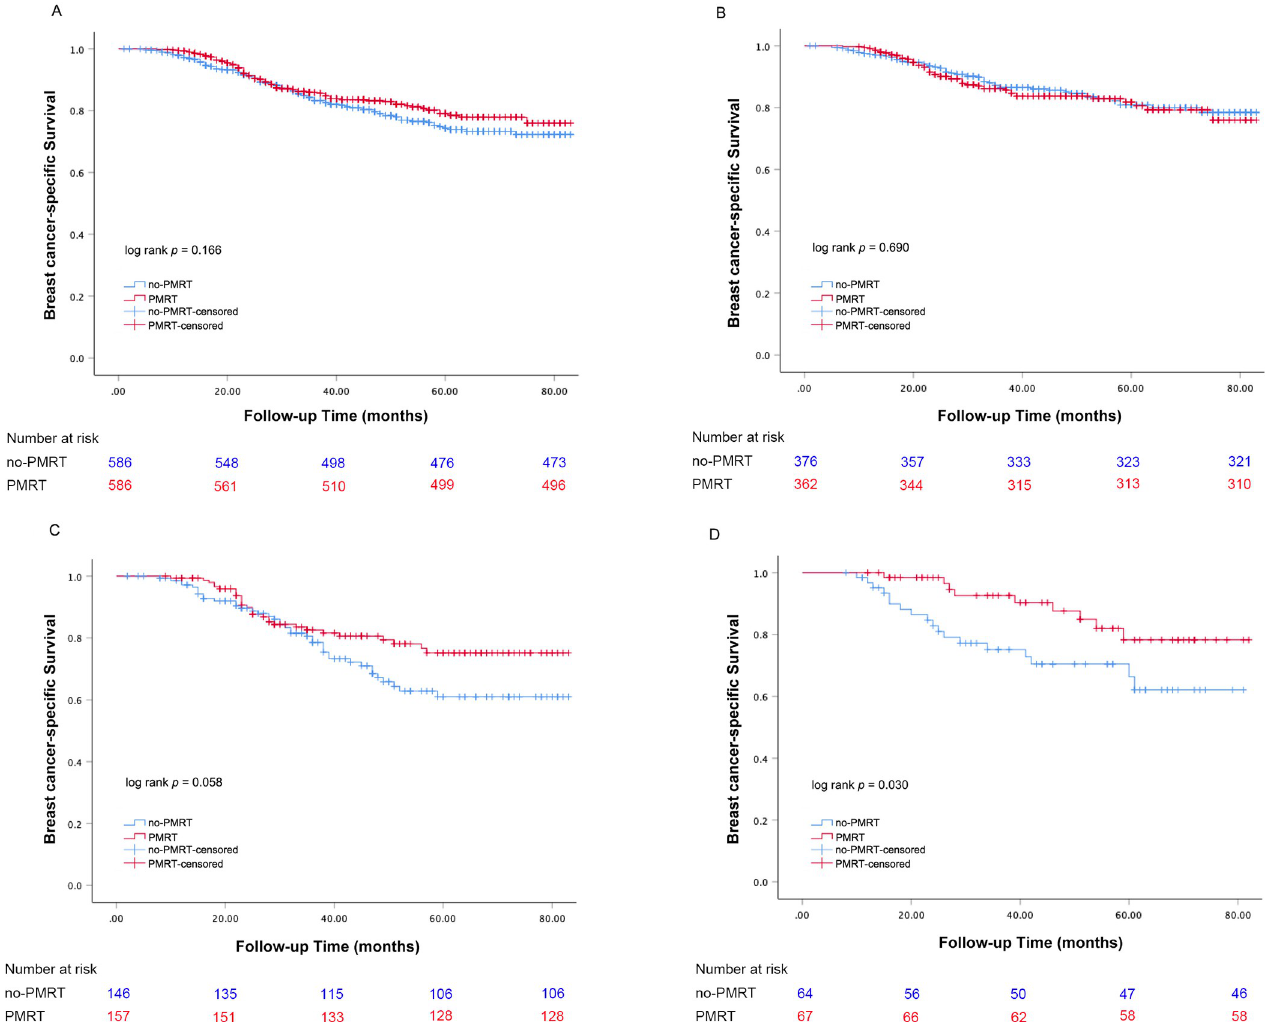
Fig 1. Kaplan-Meier curves of BCSS for T1-2N1M0 TNBC patients with and without PMRT: (A) all patients; (B) patients with one positive LN; (C) patients with two positive LNs; (D) patients with three positive LNs.